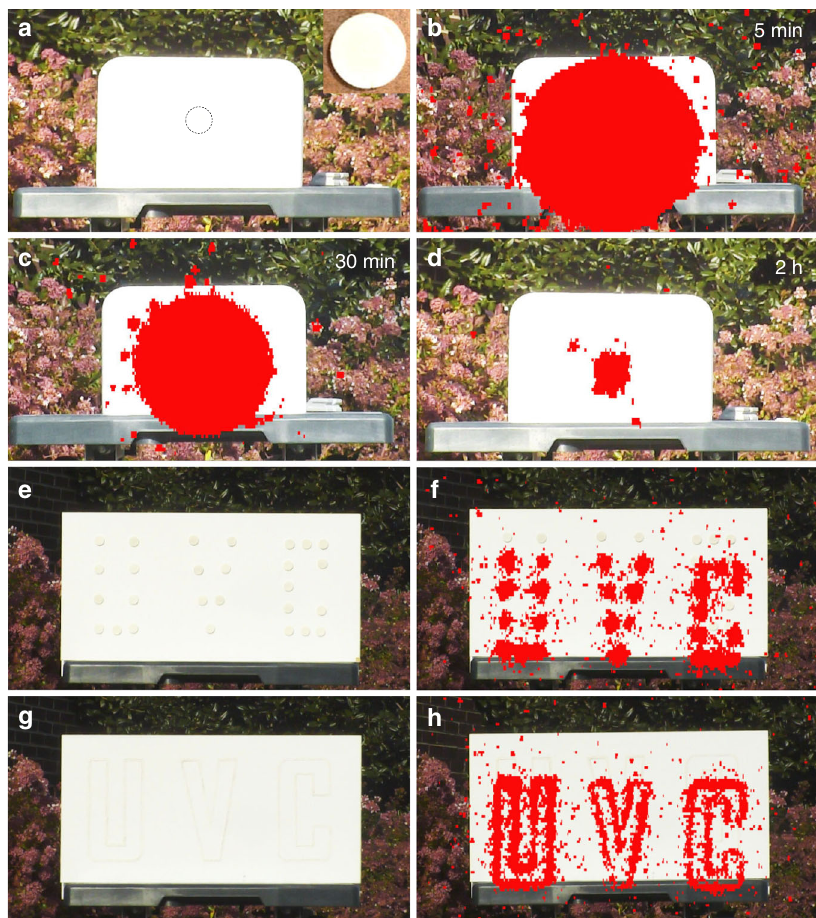
Fig. 2 Ultraviolet-C images of decaying Ca 2 Al 2 SiO 7 :Pr 3 + discs in direct sunlight. a Visible image of a 50 mm diameter white-color disc adhered on a white foam board. The position of the disc is indicated by a dash-line circle. Inset shows the white disc on a darker background. b – d Ultraviolet-C (UVC) images of the disc taken at 5 min, 30 min, and 2 h decay using a corona camera. e Visible image of letters “ U ” , “ V ” , and “ C ” made of 20 mm diameter discs on a white wood board. f UVC image of the disc letters taken at 2 min decay. g Visible image of hollow letters “ U ” , “ V ” , and “ C ” written using UVC paint on a white wood board. h UVC image of the paint letters taken at 2 min decay. In these imaging experiments, the samples were pre-irradiated by a 254 nm lamp for 2 min. The camera was located about 8 m away from the samples. The UVC radiation is represented by red